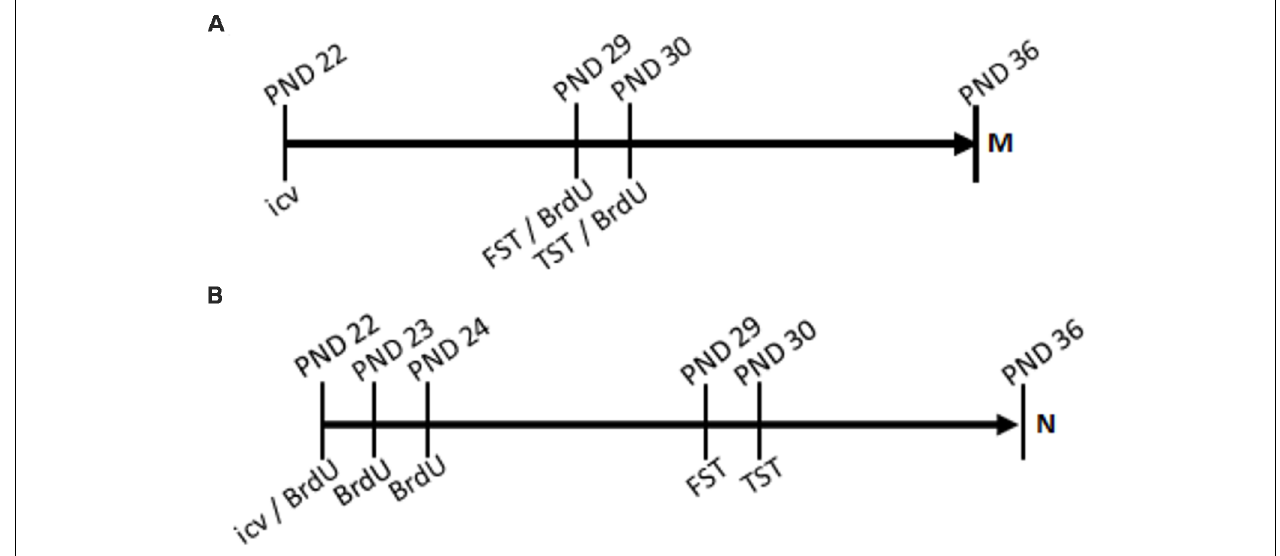
FIGURE 1 | Timelines. Treatment of ghrelin or artificial cerebrospinal fluid (aCSF) control was administered by intracerebroventricular (icv) injection acutely at post-natal day 22 (PND 22). In the mitogenic paradigm (A) , 5 (cid:48) -bromo-2 (cid:48) -deoxyuridine (BrdU) was administered by intraperitoneal (ip) injection three times daily for two consecutive days, PND29 and PND30. In the neurogenic paradigm (B) , BrdU was administered twice daily for three consecutive days, PND22, PND23, and PND24.